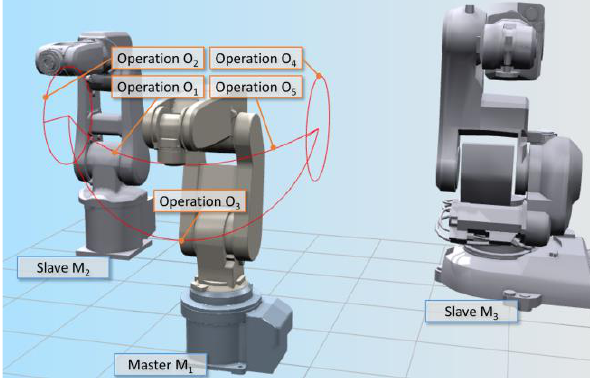
Figure 16. Heterogeneous multi-robotic cell.